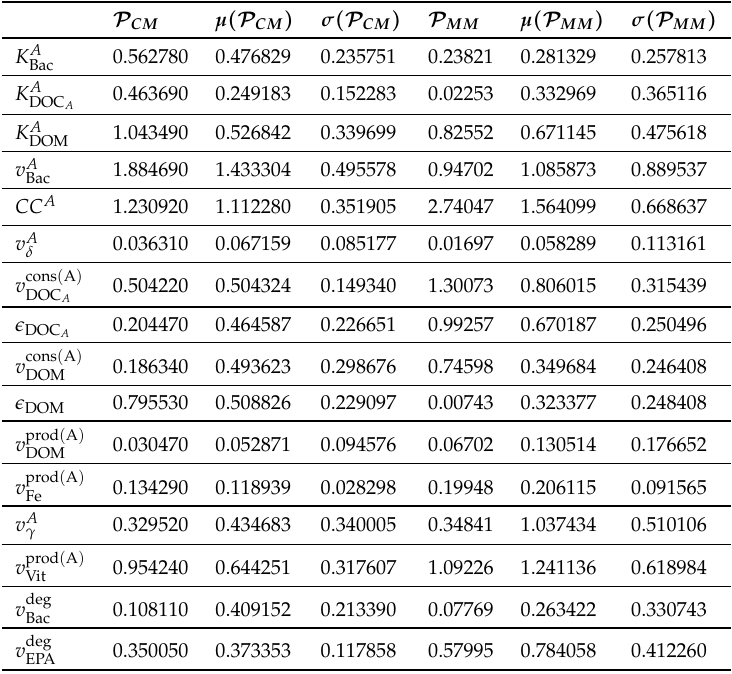
Table A4. Final parameter sets used for simulation in CM ( P CM ) and MM ( P MM ). Also reported are the overall average and standard deviation values from all the last rounds of